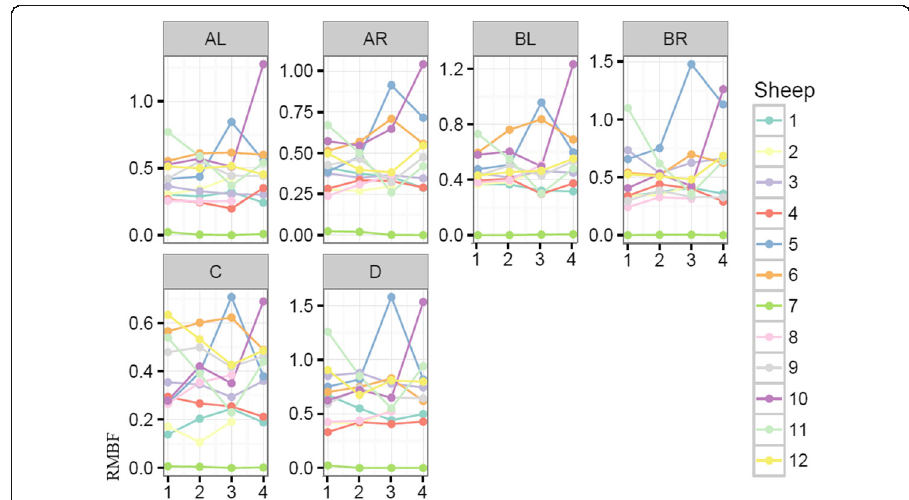
region of interest over time. Time-points (T1 – T4) on the x axis; RMBF per 1 g tissue on the y axis